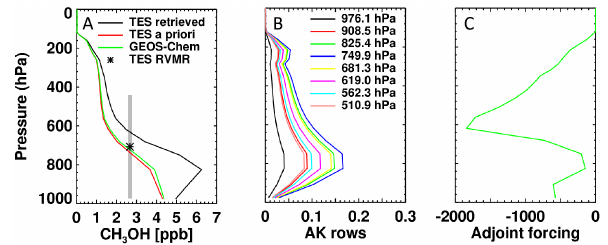
Fig. 3. Example of a TES methanol retrieval and corresponding Figure 3. Example TES methanol retrieval and corresponding adjoint forcing. (A) Retrieved 2 adjoint forcing. (A) Retrieved methanol profile (black line), with methanol profile (black line), with the a priori profile (red line), the GEOS-Chem model profile 3 the a priori profile (red line), the GEOS-Chem model profile with with the TES a priori and averaging kernel applied (green line), and the TES representative 4 the TES a priori and averaging kernel applied (green line), and the volume mixing ratio (RVMR, black symbol). The shaded bar indicates the vertical range over 5 TES representative volume mixing ratio (RVMR, black symbol). which the RVMR applies, corresponding to the full width at half-maximum of the averaging 6 The shaded bar indicates the vertical range over which the RVMR kernel peak. (B) Rows of the averaging kernel for this retrieval, which has 0.78 degrees of 7 applies, corresponding to the full width at half-maximum of the averaging kernel peak. (B) Rows of the averaging kernel for this freedom for signal (DOFS). (C) The corresponding adjoint forcing ( ∂ J/ ∂ p ) for this example. 8 retrieval, which has 0.78 degrees of freedom for signal (DOFS).